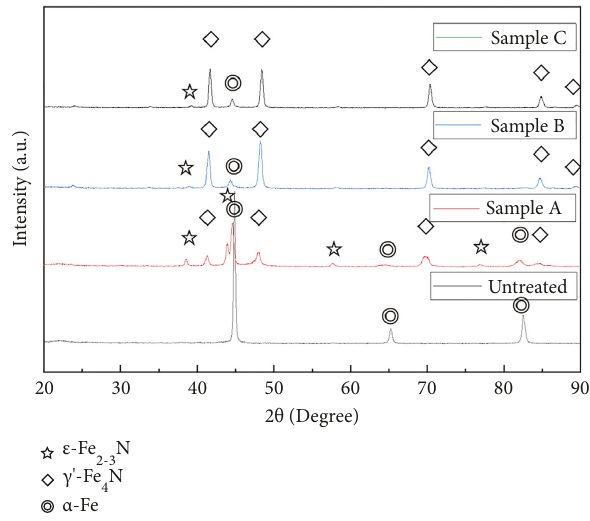
Figure 3: XRD patterns of the untreated and ion-nitrided